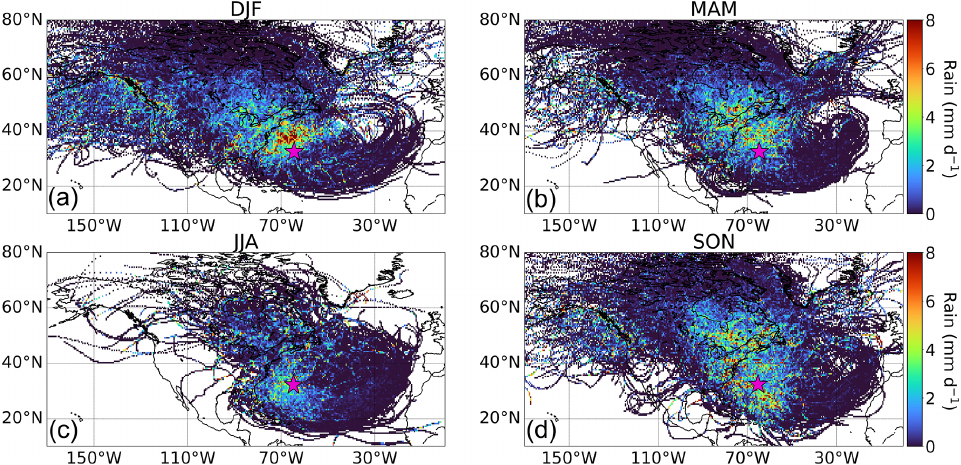
Figure 3. Seasonal maps (a–d) of average precipitation occurring in 0.5 ◦ × 0.5 ◦ grids based on 10d backward trajectories reaching Bermuda (32.30 ◦ N, 64.77 ◦ W; pink star) at 100m (a.g.l.). This analysis is based on trajectories between 1 January 2015 and 31 December 2019.